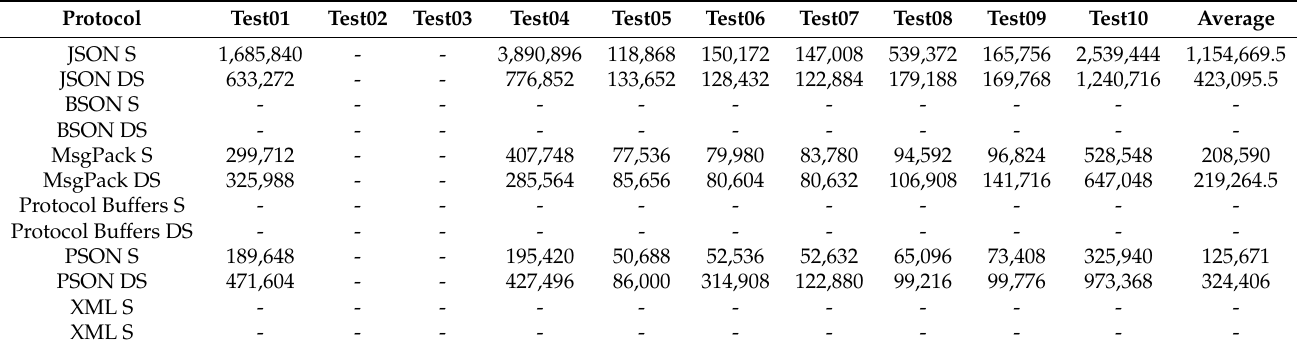
Table 4. Arduino UNO Serialization (S)/Deserialization (DS)